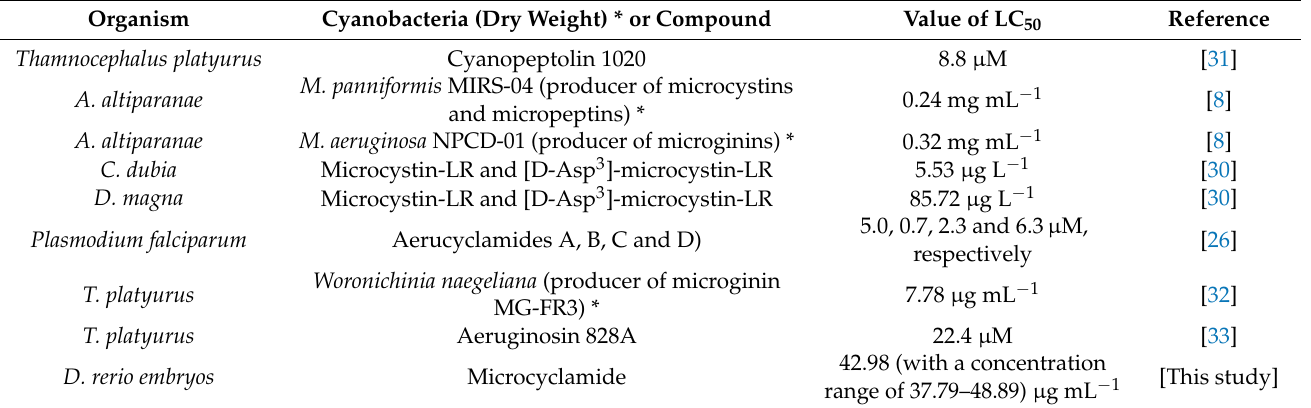
Table 1. LC 50 values of cyclamides (or other secondary metabolites) and cyanobacteria (dry